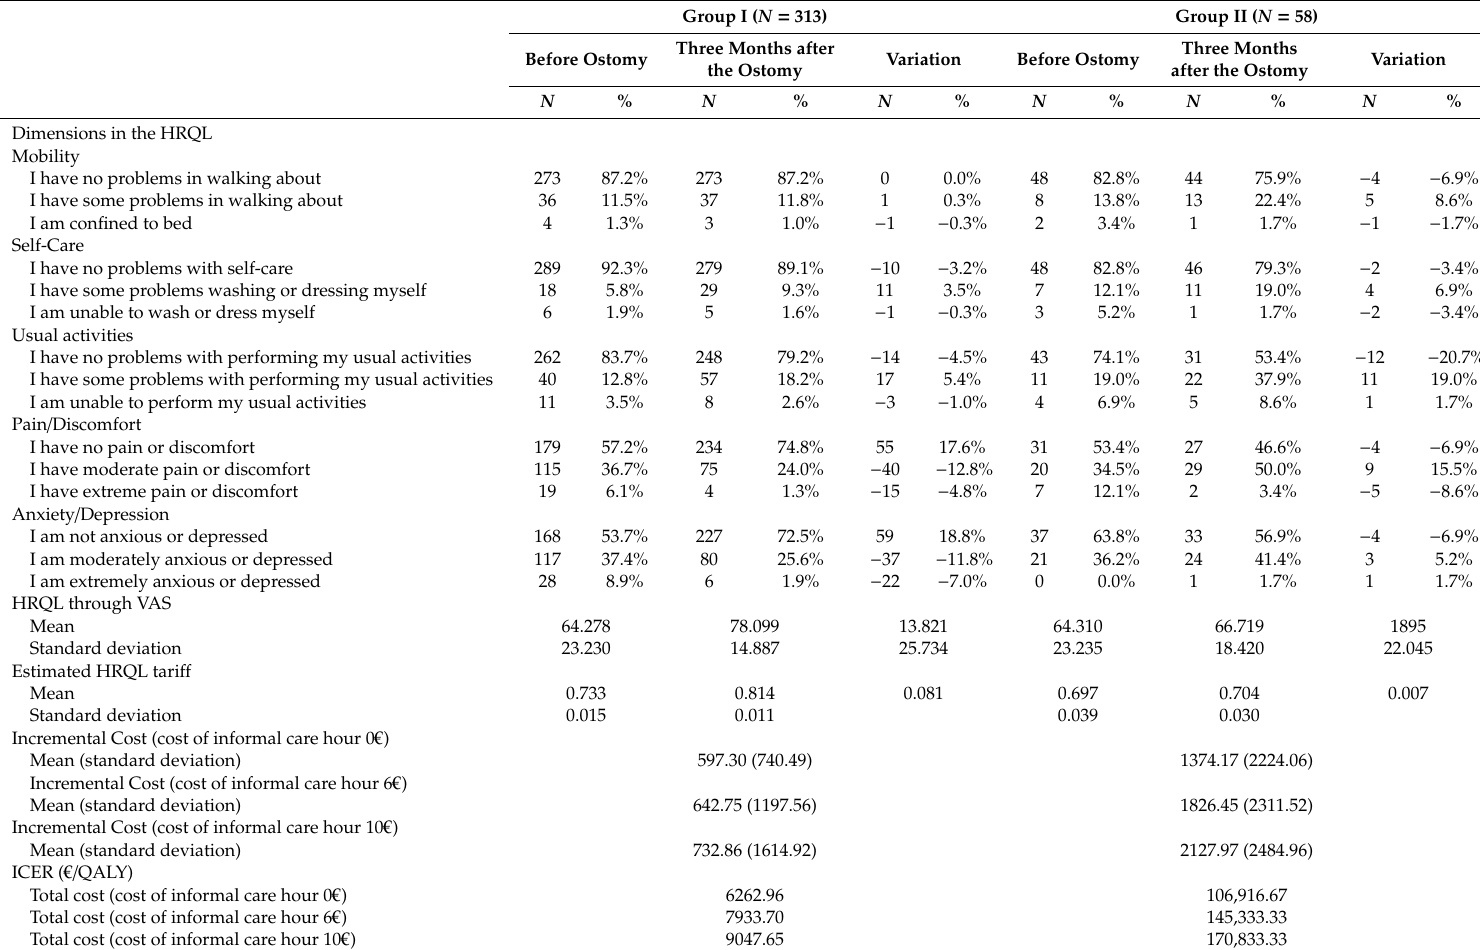
Table 4. Evolution of the health-related quality of life (HRQL) and incremental cost e ff ectiveness ratio (ICER) in stoma patients. VAS: Visual Analogue Scale. Group I ( N = 313) Group II ( N = 58) Before